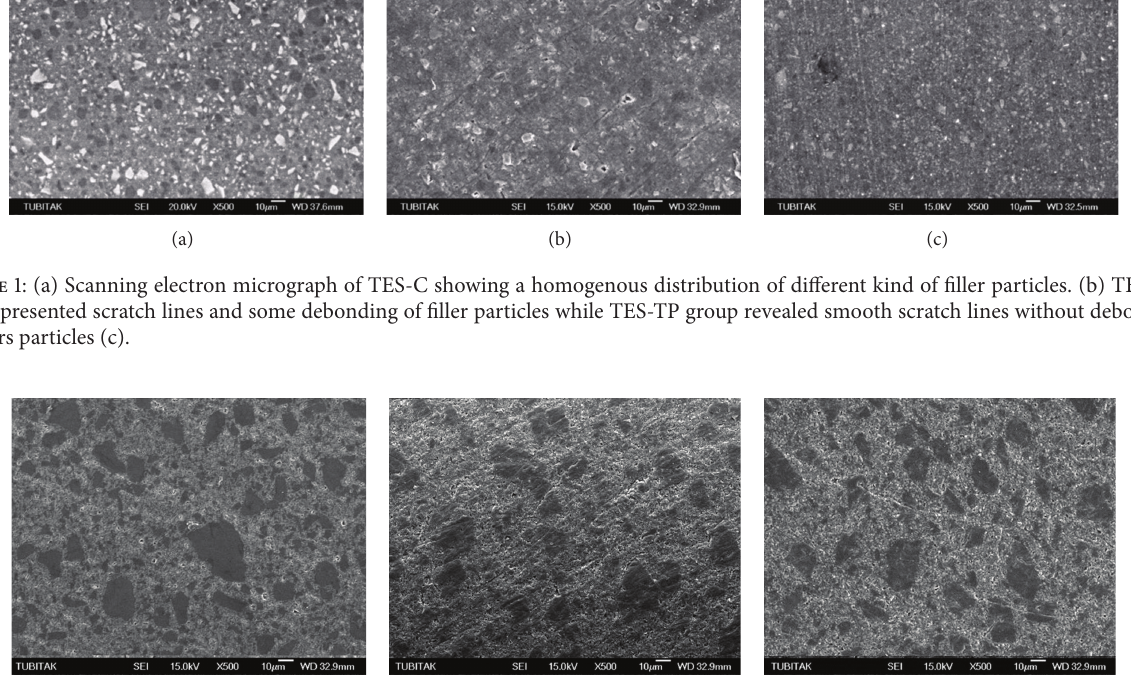
Table 2: Mean surface roughness ( 𝑅 𝑎 ; 𝜇 m), standard deviations ( ± sd), and statistical analysis of the control and prophylactic polishing paste (PPP) applied indirect restorative materials. Indirect restorative